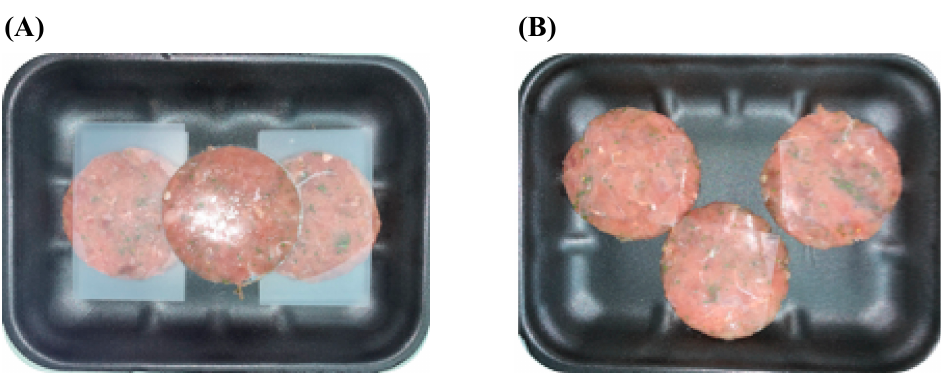
Figure 6. Representative scheme of preparation of Sarda sarda burgers employed in the microbiological and physico-chemical analyses. ( A ) Burgers of Sarda sarda treated with PPs films not-functionalized with 1018K6 (CTR); ( B ) burgers of Sarda sarda treated with PPs films functionalized with 1018K6